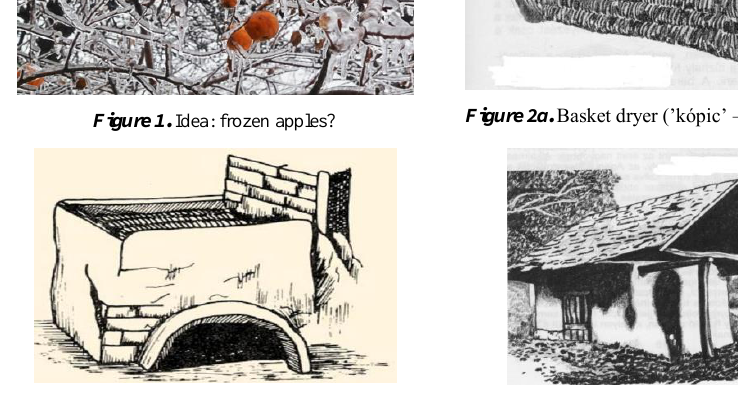
Figure 3. Simple drying equipment (Rétköz) Figure 4. Straight dryer housing in Szatmár Figure 5a. Modern solar dryer